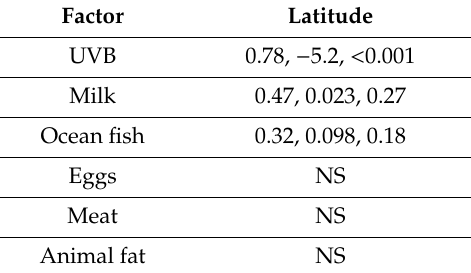
Table 7. Cross-correlation for various factors with latitude for the 19-country study.